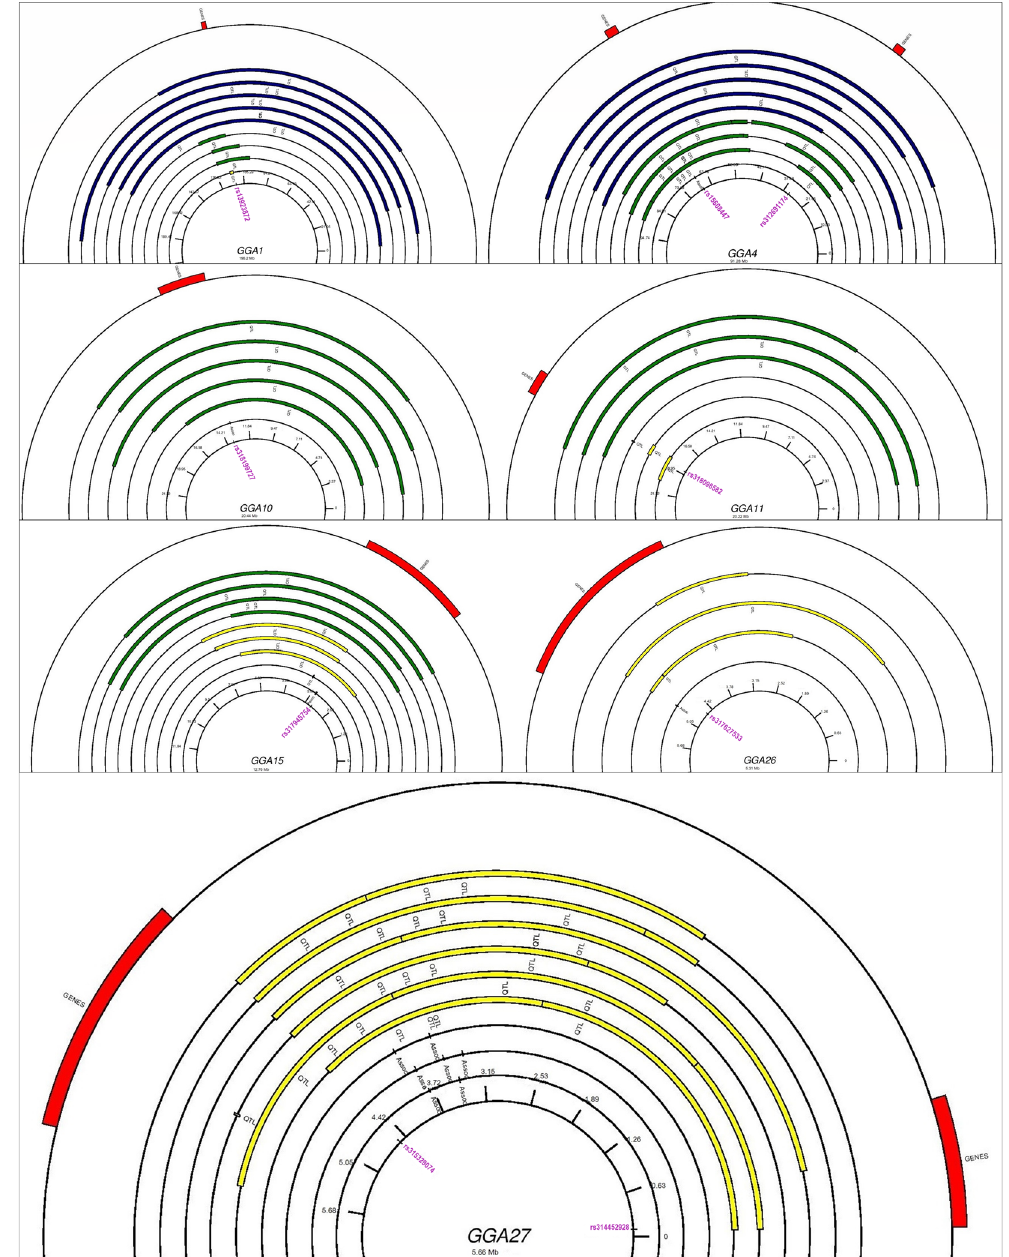
Figure 2. Circular chromosome maps for seven autosomes presenting combined data of reported QTL (n = 183) and positional candidate genes (n = 462). Blue color represents the extent of large sized QTL (50– 196.2 Mb), green color the medium sized QTL (5–50 Mb) and the yellow color is indicative of the small QTL (0–5 Mb). Red color indicates the starting and ending positions of positional candidate genes. The position(s) of the significant SNPs (labeled in purple color) is also given. The figure was constructed using GenomeVx 87